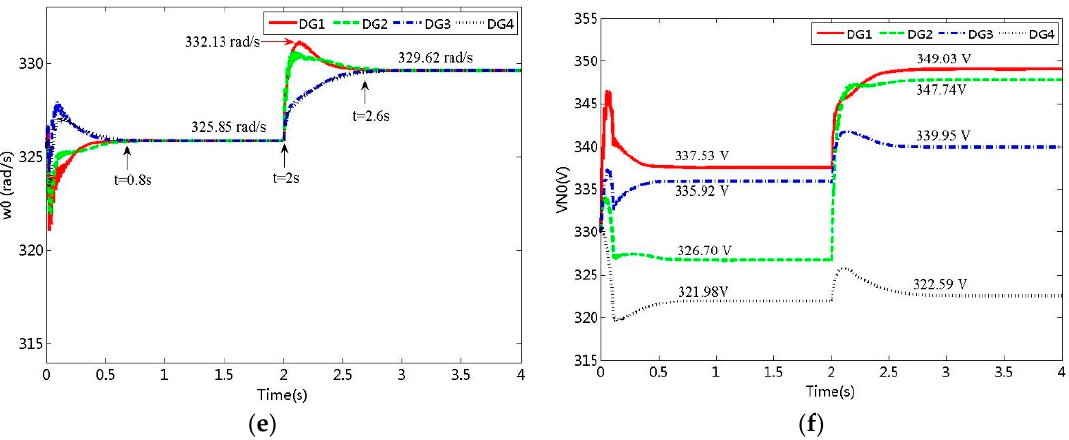
Figure 9. Simulation results without time-delays and disturbance. ( a ) Frequency; ( b ) active power of each DG; ( c ) voltage; ( d ) reactive power of each DG; ( e ) adaptive ω oi ; ( f ) adaptive V oi .